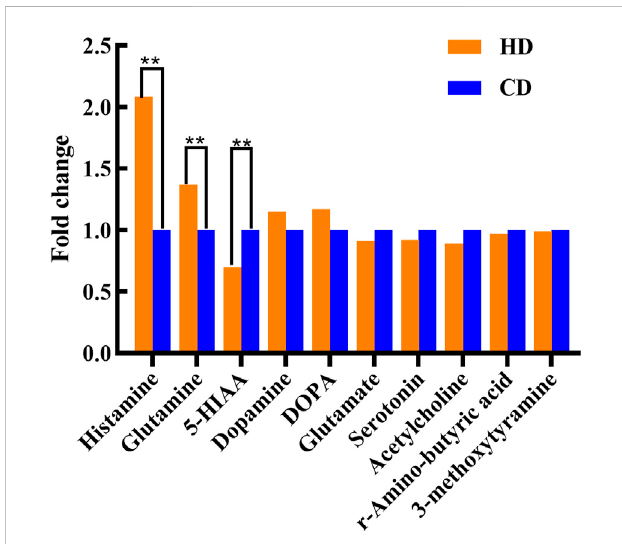
FIGURE 3 Changes in serum neurotransmitters, as detected by targeted metabolomics analysis. Compared with the CD group, ** p <